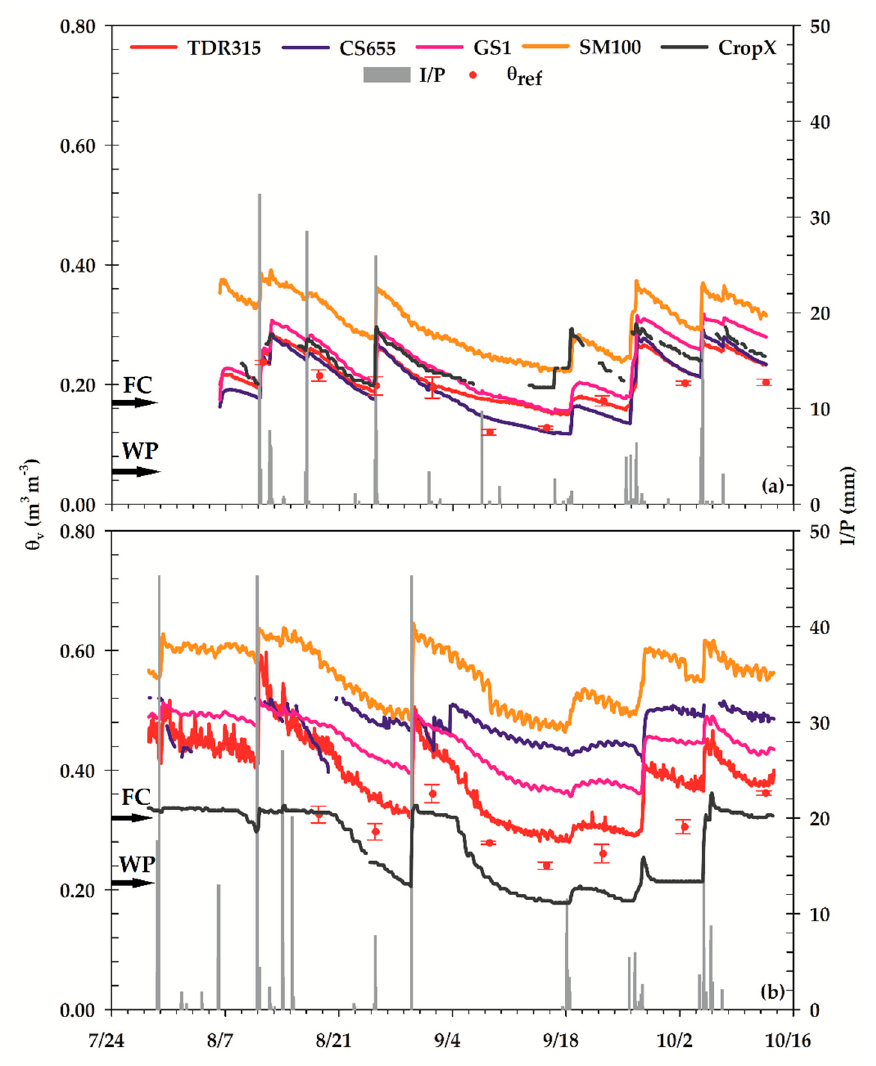
Figure 2. Time series of sensor-estimated θ v along with point measurements of θ ref at ( a ) lower salinity and lower clay content (LSLC) and ( b ) higher salinity and higher clay content (HSHC) sites. Error bars for θ ref represent standard error of mean. The FC and WP limits were determined in the laboratory.